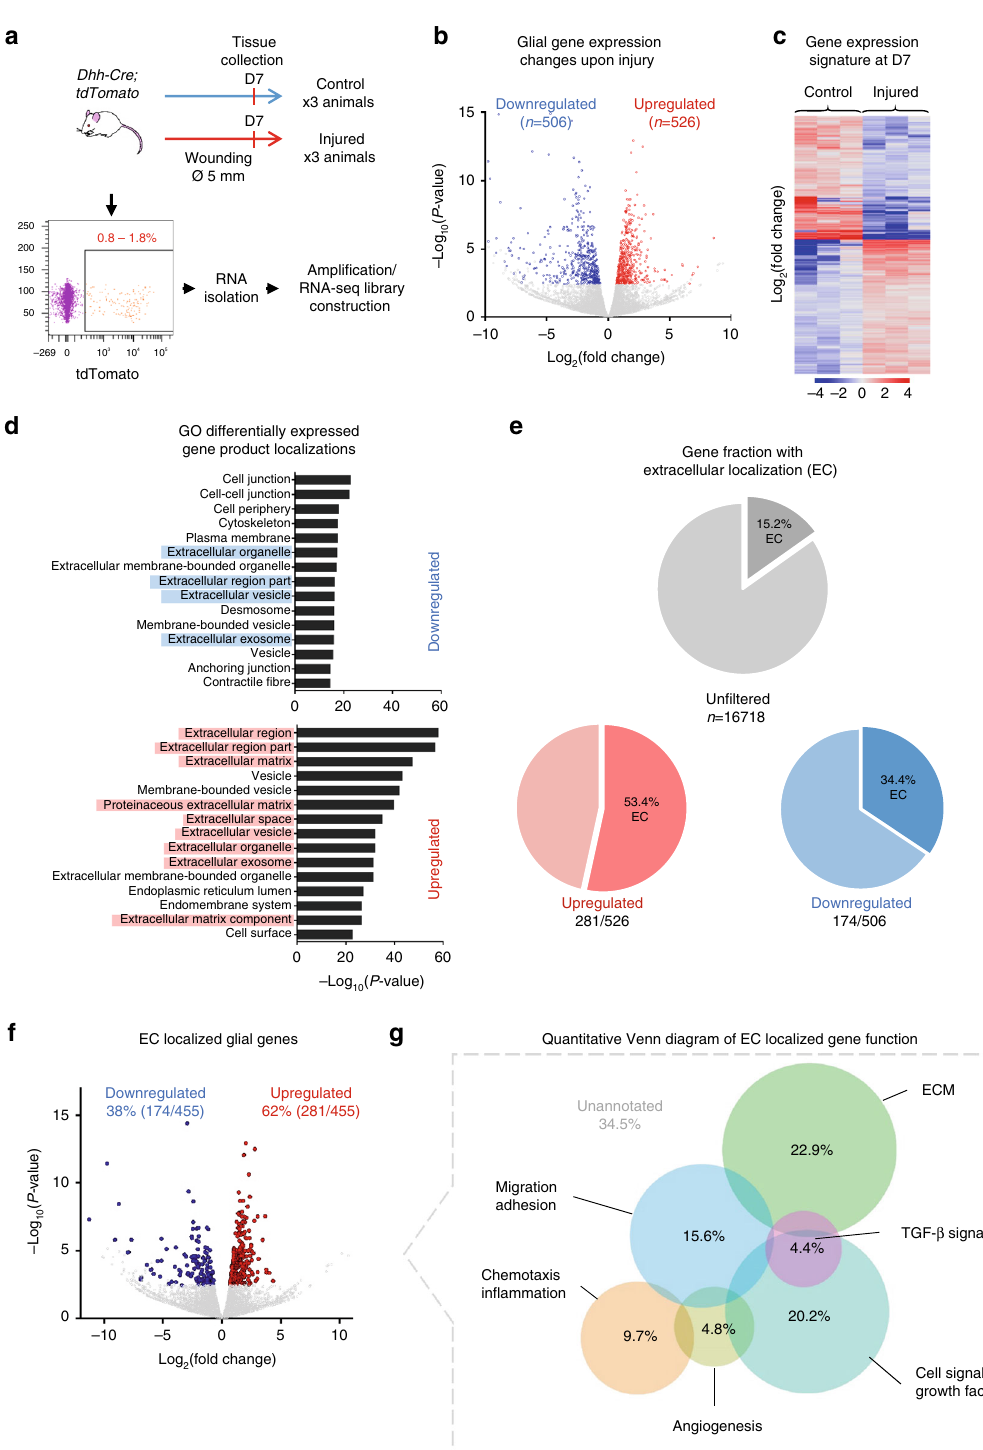
Fig. 3 Expression pro fi le analysis of glial lineage upon skin injury. a Experimental design for skin sample collection of Ctrl and D7-injured Dhh-Cre; tdTomato animals. Single cell suspensions were sorted for tdTomato expression using a fl ow cytometer (0.8 – 1.8% of total cell fraction). Total RNA samples of gated cells were ampli fi ed and subsequently subjected to RNA-Seq using Illumina RNA-Seq platform. b Volcano plot of the gene expression pro fi le of Dhh-Cre - traced tdTomato + cells of intact skin and D7 post injury. Coloured data points meet the thresholds of FC above 1.5 and under − 1.5, P -value < 0.05, FDR < 0.05. c Unsupervised sample clustering heat map of gene expression with a signi fi cantly differential expression. d Gene GO MetaCore prediction of the product localisation of the signi fi cantly downregulated (506 genes) and upregulated genes (526 genes) shows a signi fi cant enrichment of genes, the products of which are excreted. e Data representation for the percentage of gene products predicted to be destined to the extracellular space. f Volcano plot of the expression value of the genes with predicted extracellular localisation of their product. g Quantitative Venn diagram of the differentially expressed “ secretome ” and the associated biological